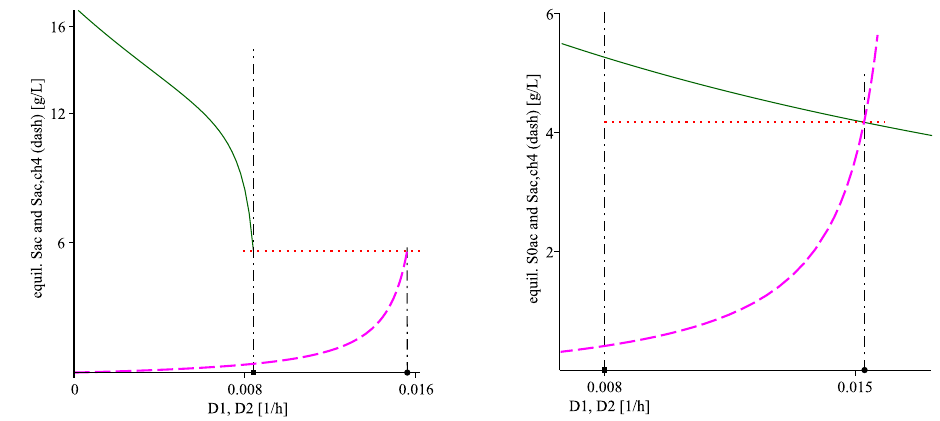
( 2 ) ) (left plot) and for D 2